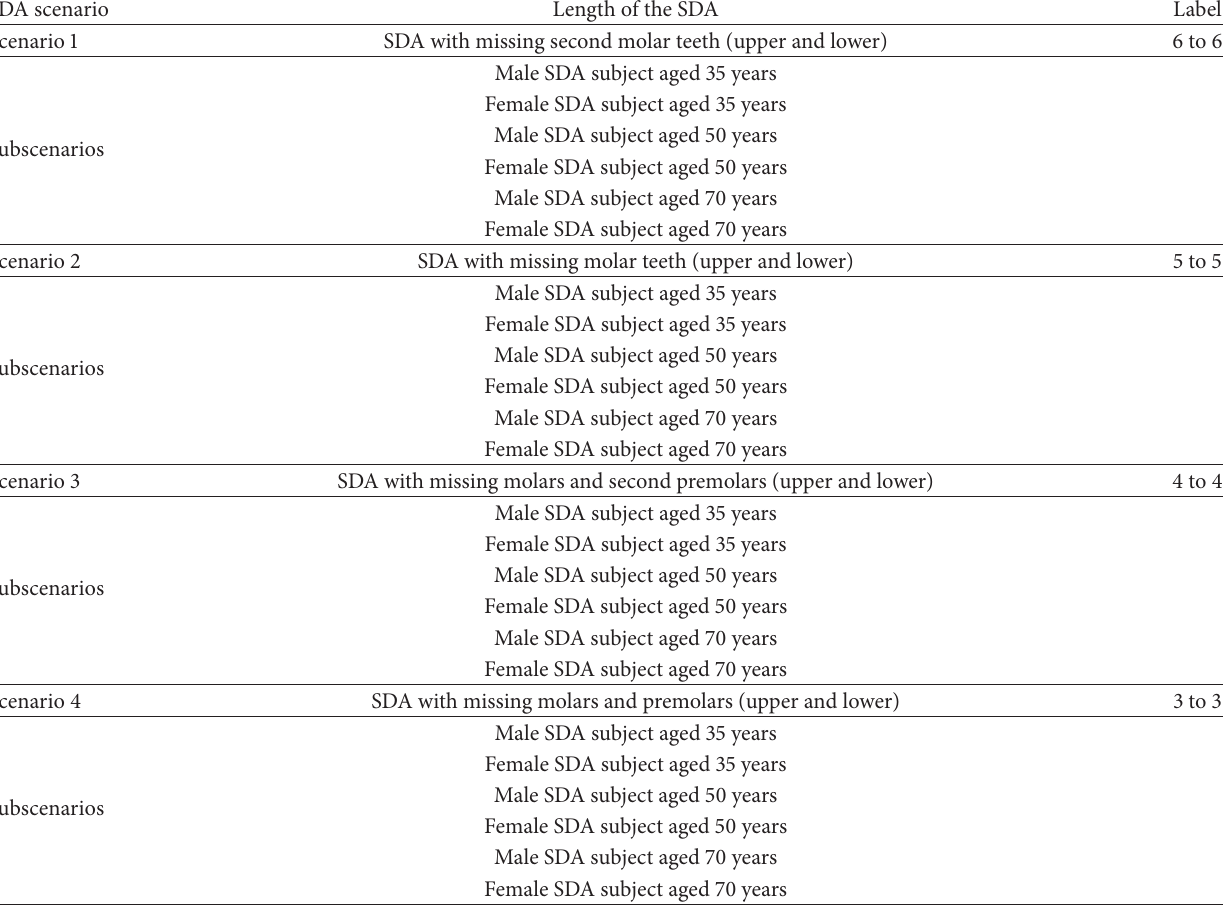
Table 1: Shortened dental arch scenarios used in this